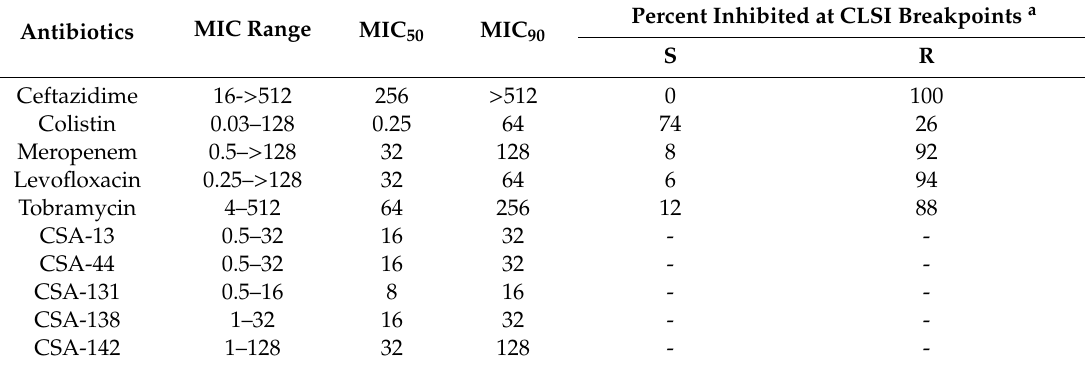
Table 1. Comparative in vitro activity of antimicrobial agents against 50 isolates of multidrug-resistant (MDR) K. pneumoniae (mg /